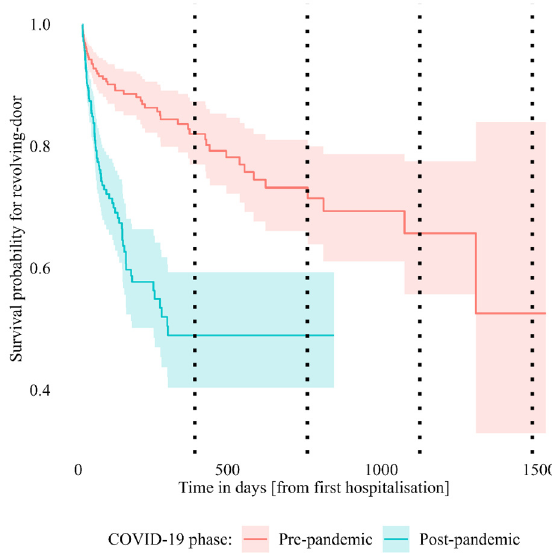
Figure 1. Survival probability for revolving-door in days from the first hospitalization of the patient, before and after the onset of COVID-19 pandemic. Kaplan–Meier’s curve with 95% confidence interval; dotted lines indicate a 1-year interval.